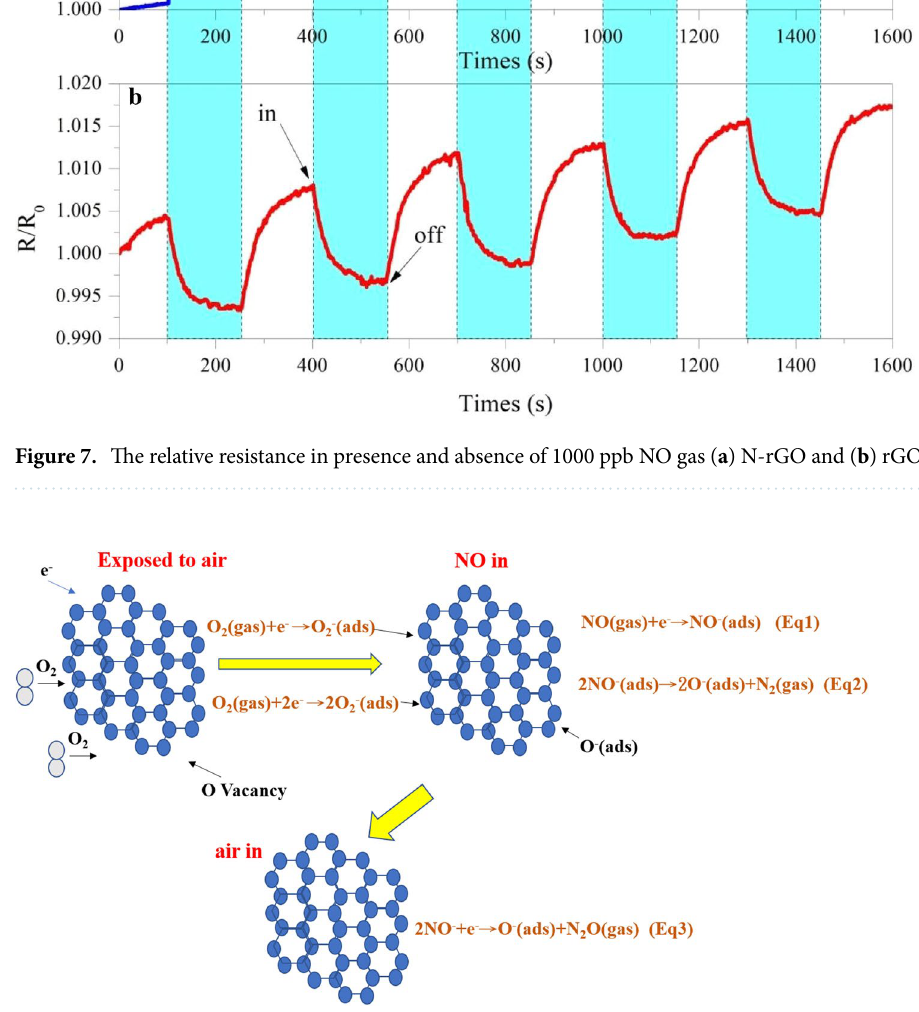
Figure 8. Schematic view of sensing mechanism of N-rGO sensor with NO